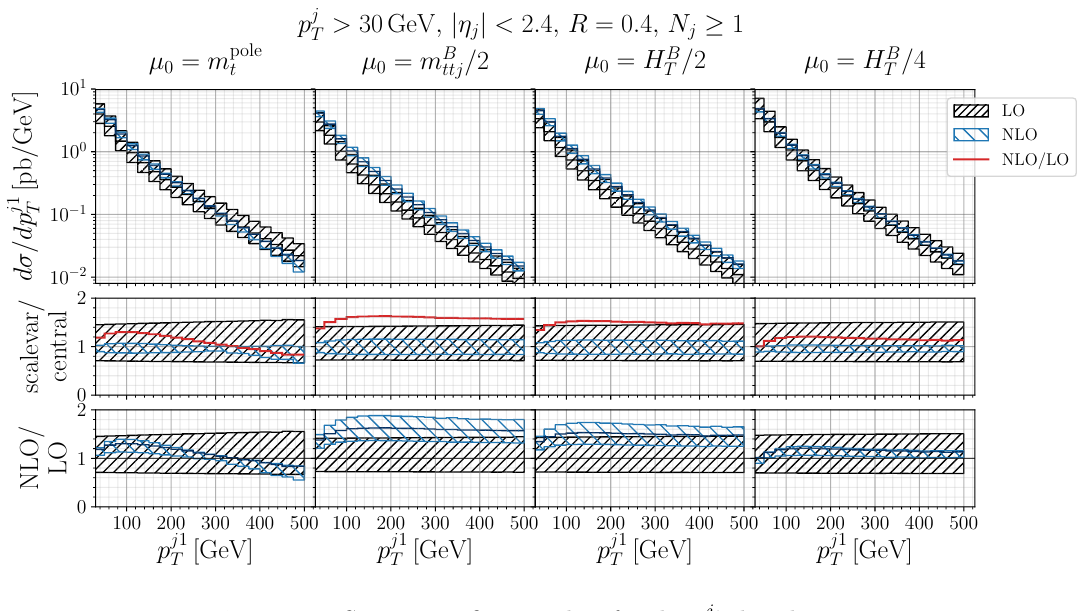
Figure 14 . Same as in figure 7, but for the p j 1